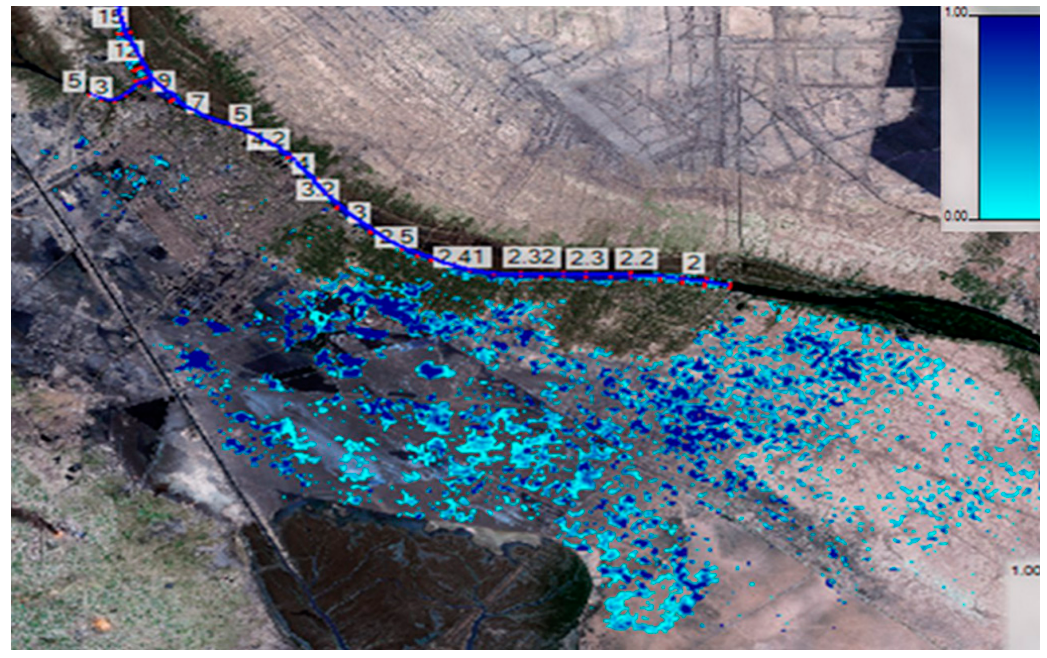
Figure 23. Flood extent generated by HEC-RAS 5.03 at the end of the wave period for case B3. Table 2. Flood hazard classification based on water depth and velocity